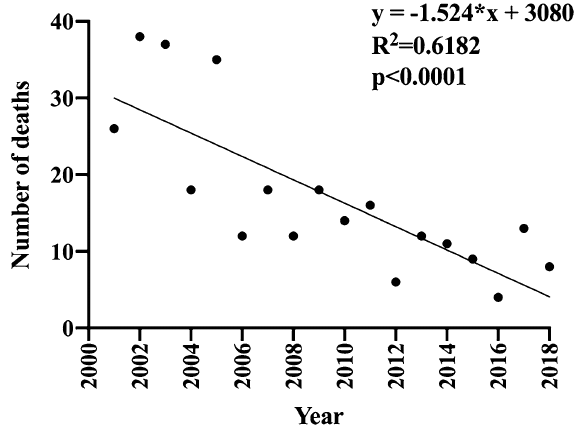
Figure 1. The time trend of CO poisoning cases in Shanghai, China. Linear regression analysis was performed and the correlation coefficiency was